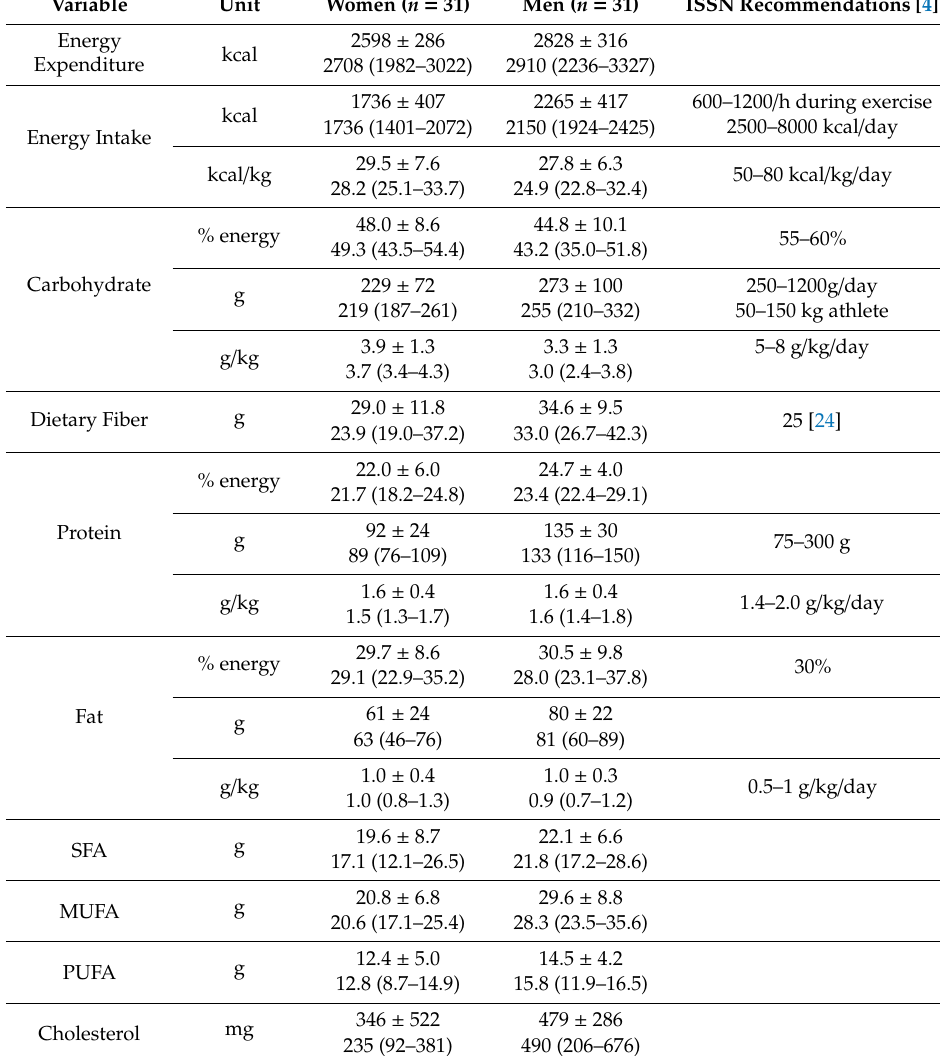
Table 2. Mean values of energy and macronutrients intake in CrossFit